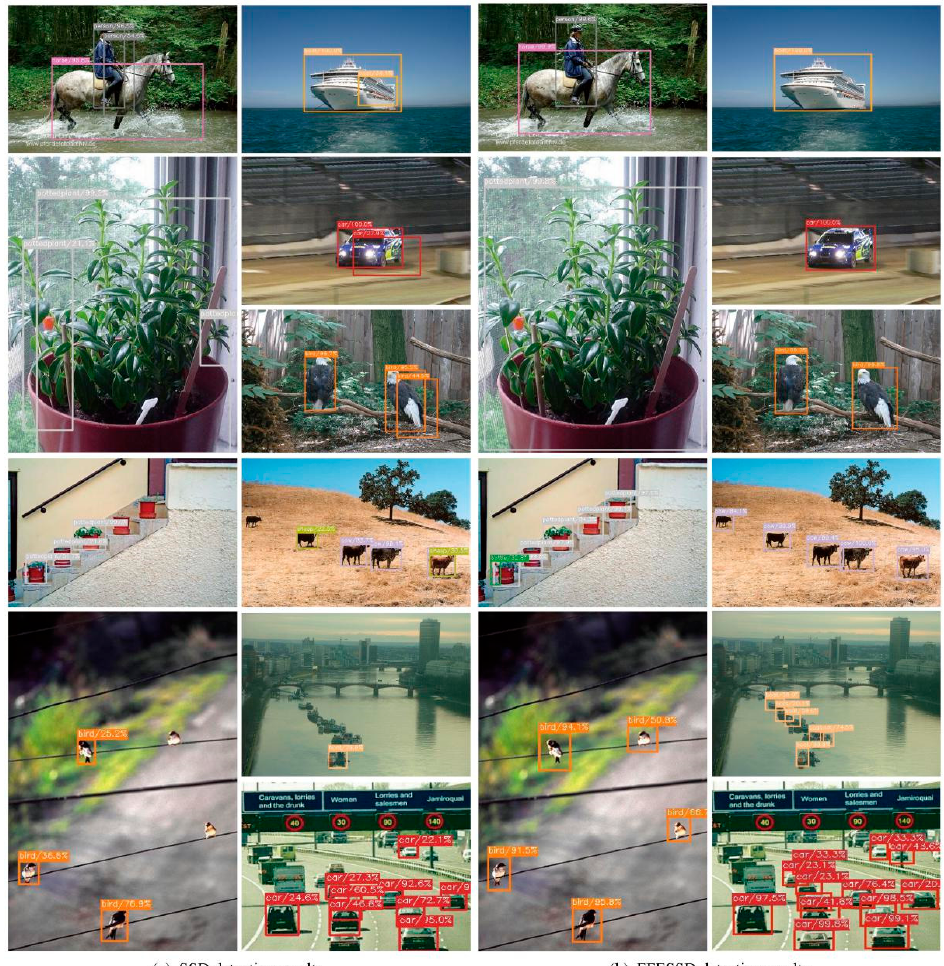
Figure 4. Detection examples on the Pascal VOC 2007 test dataset with SSD300 / FFESSD300 model. ( a ) The images are the results of the SSD. ( b ) The images are the results of the Single Shot Object Detection with Feature Enhancement and Fusion (FFESSD).